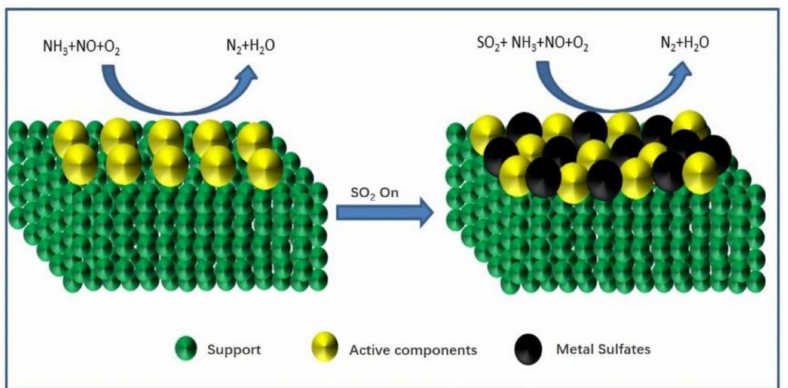
Figure 2. Sulfation of active components.